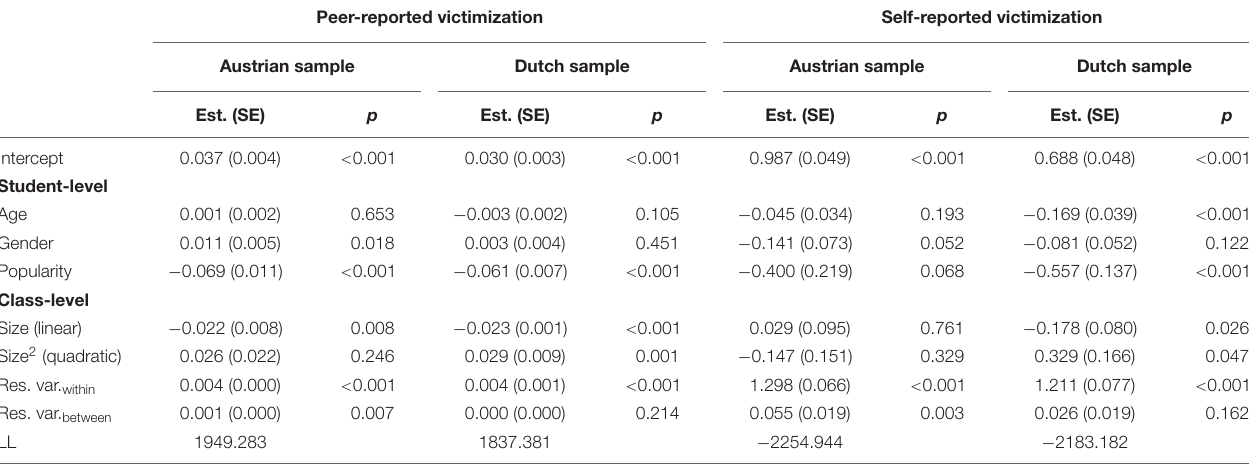
TABLE 3 | Main effects of age, gender, popularity and classroom size on peer-reported and self-reported victimization for the two samples. Peer-reported victimization